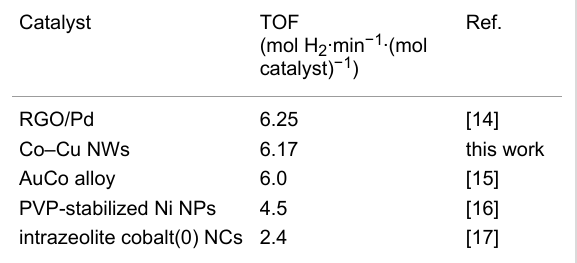
Table 1: Catalytic activity of different catalysts used for the hydrolysis of AB.